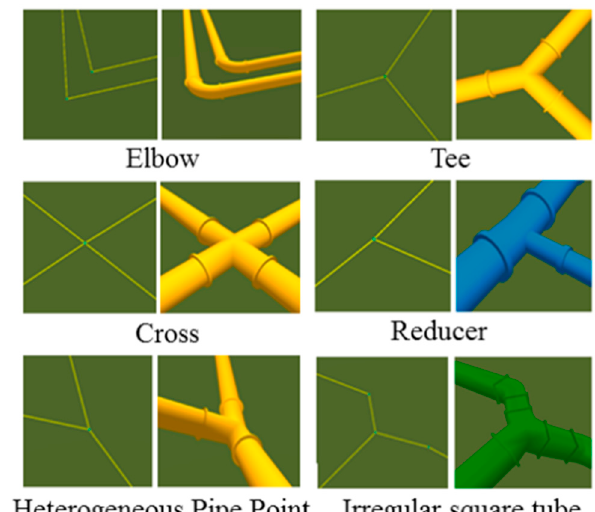
Figure 6. Pipe network models in 2D GIS and 3D GIS.